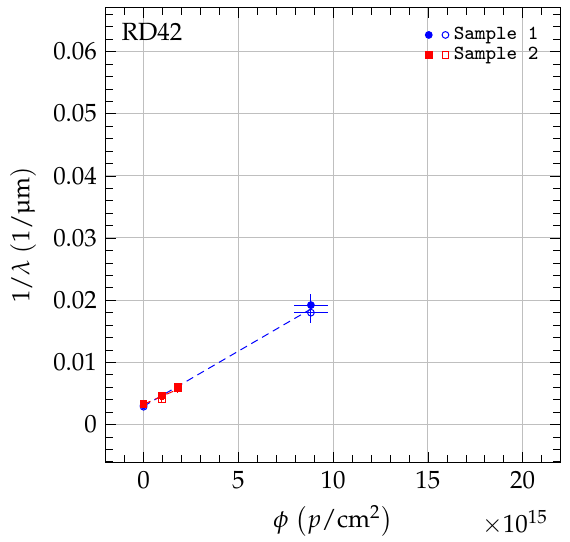
Figure 5. The 1/ λ for pCVD diamond in the 70MeV proton irradiation. The two values shown at each fluence are the values for positive (solid markers) and negative (open markers) bias at E = The data were fit with a first-order damage curve independently for each